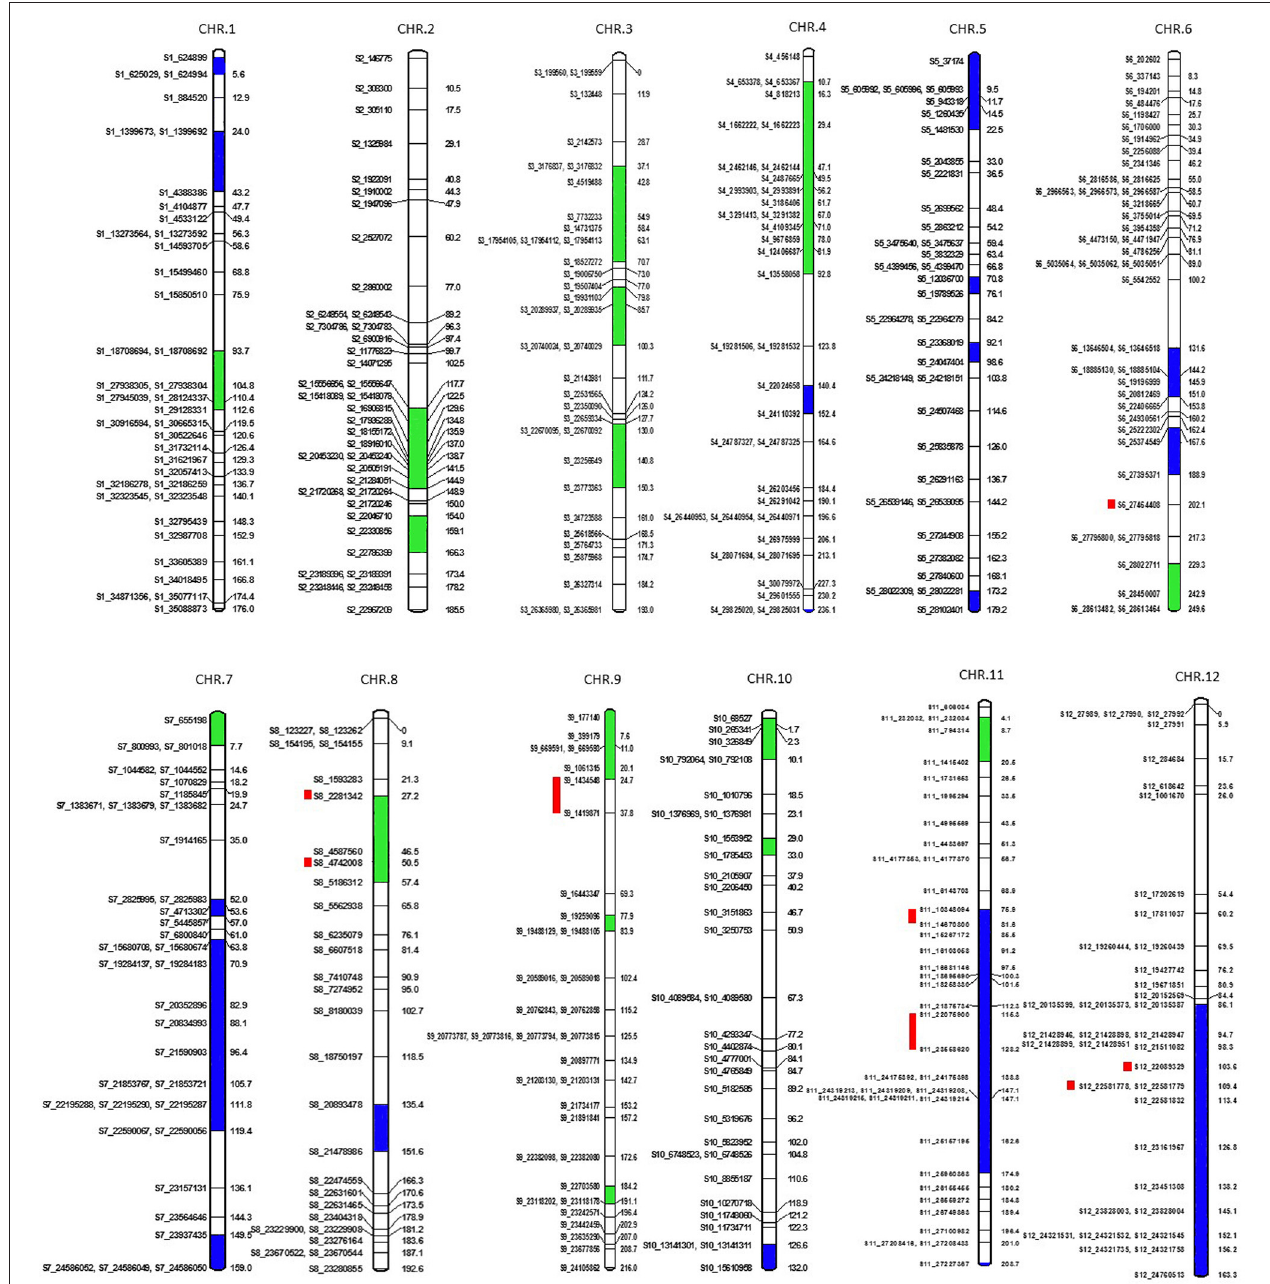
FIGURE 5 | Genetic map showing positions of skeletal markers on which a high-density genetic map is constructed. Blue is segregation distortion skewed toward female parent and green toward male parent. Red bars show the location of QTLs for fruit